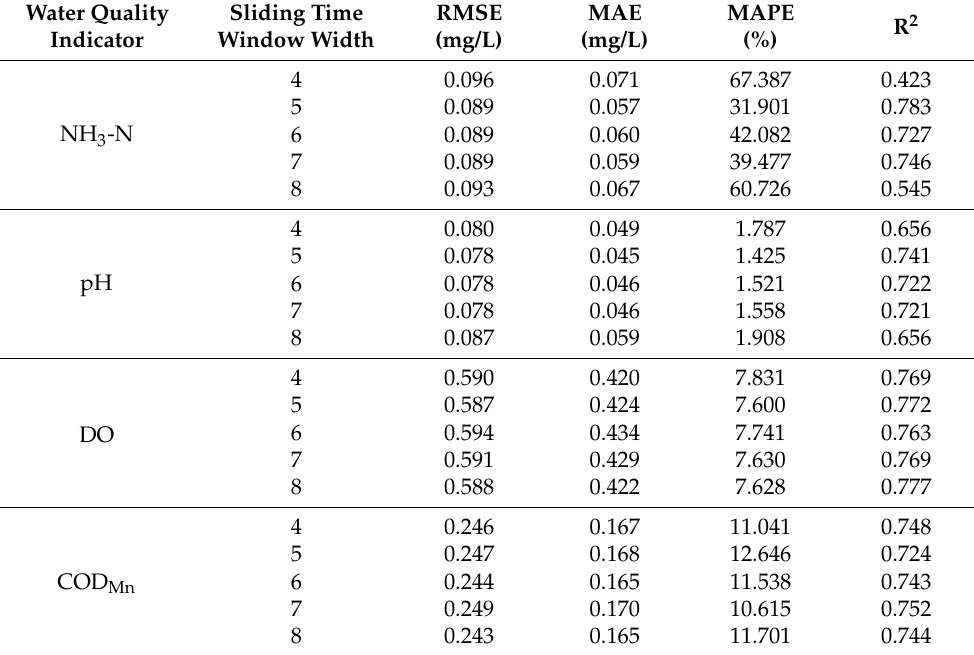
Table 4. The LSTM model performance under different sliding time window